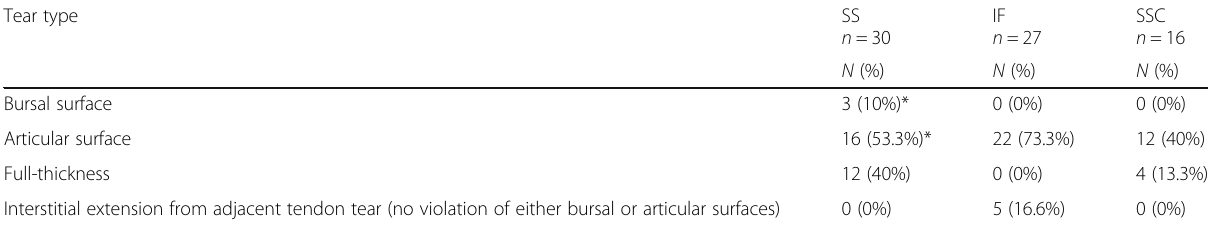
Table 1 Types of rotator cuff tear depending on the violated